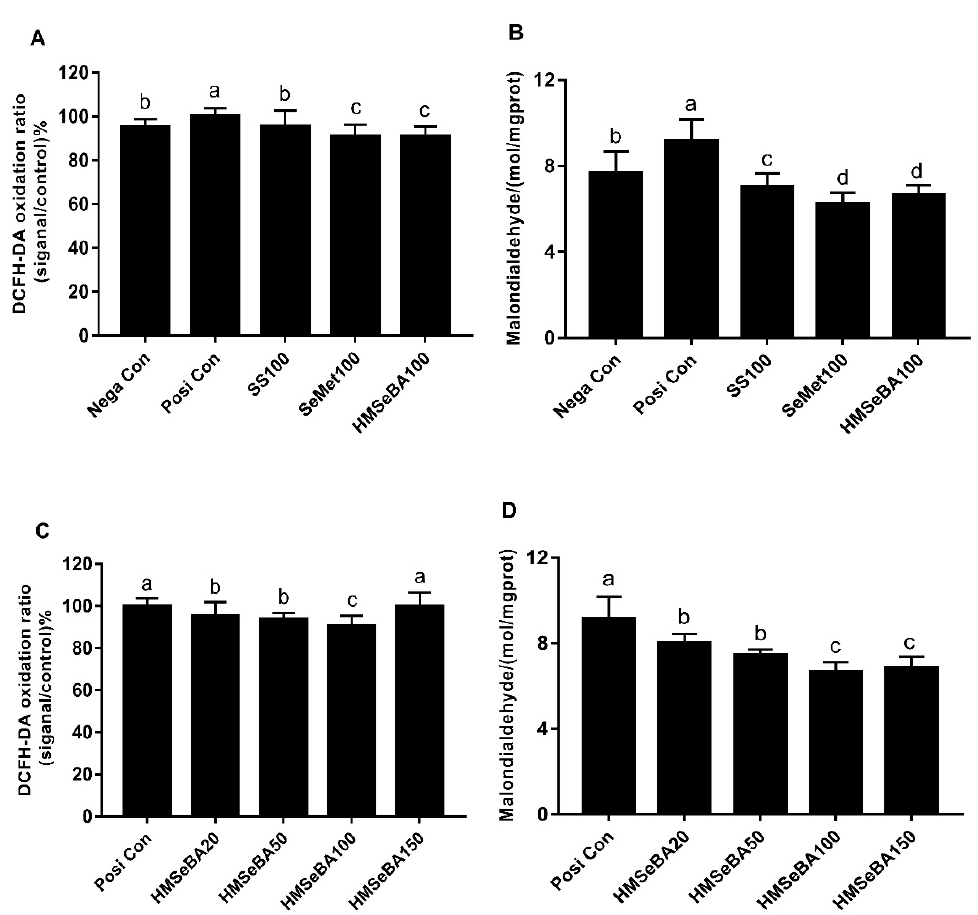
Figure 2. Effect of different Se sources and HMSeBA levels on protection of BMEC against H 2 O 2 induced oxidative stress. ( A ) DCFH-DA oxidation ratio; ( B ) Malondialdehyde; ( C ) DCFH-DA oxidation; ( D ) Malondiadehyde. Nega Con, negative control (no H 2 O 2 and no Se); Posi Con, positive control (no Se, H 2 O 2 treatment); SS100, 100 nM sodium selenite supplementation; SeMet100, 100 nM